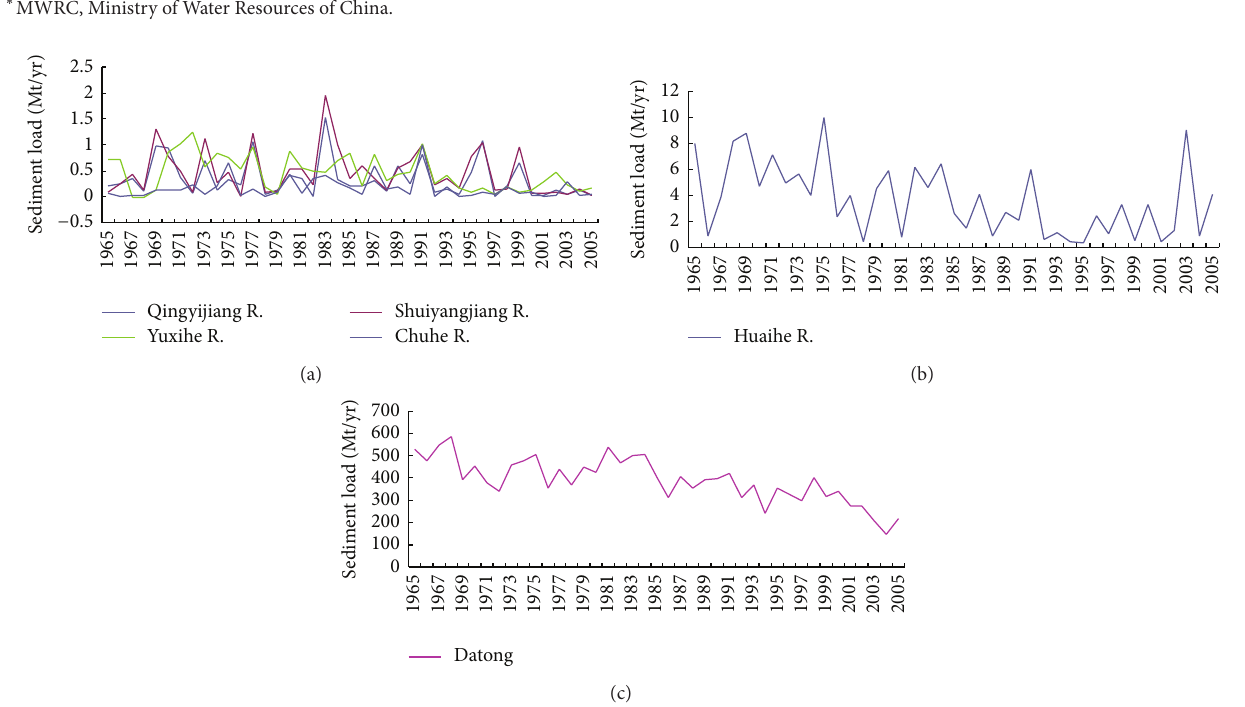
Figure 2: Variations in sediment load of local tributaries in the river mouth reach, Huaihe River, and Datong